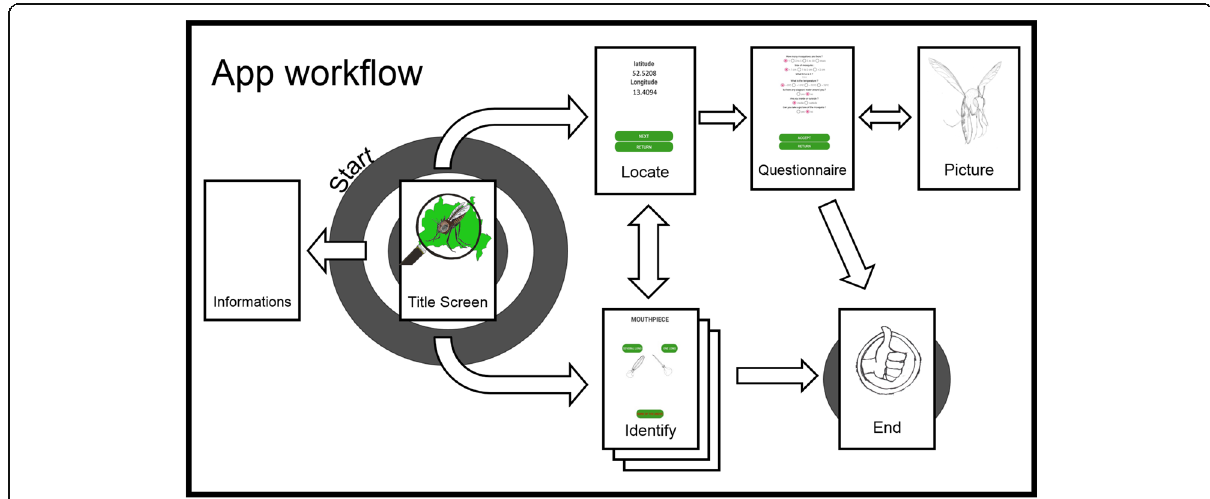
Fig. 1 Application workflow. From the title screen, a user has three choices: starting the “ locate ” activity, the “ identify ” activity or explore the information. Information contains the name of contributors and contact information. The “ locate ” activity returns the user ’ s position followed by